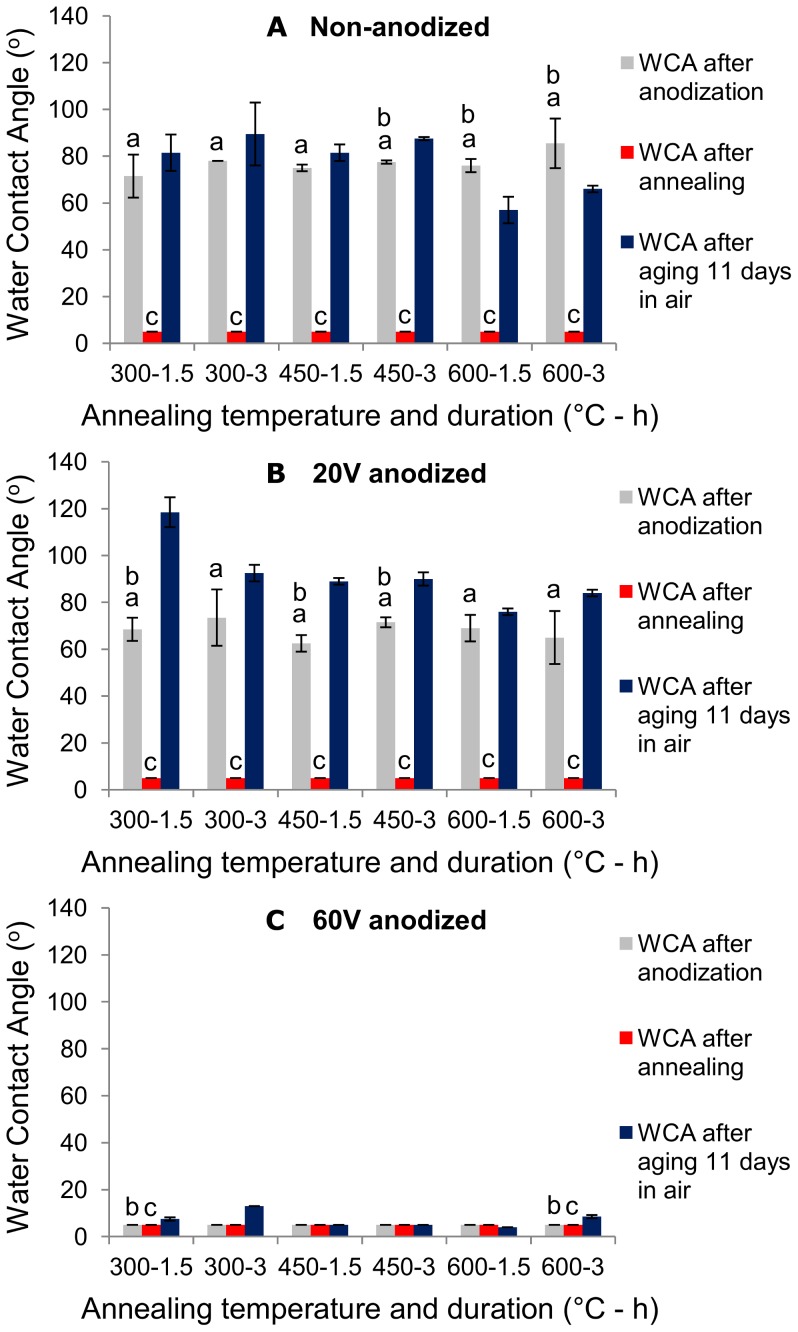
WCA measurements of the samples fabricated at different anodization and annealing conditions.WCA are shown for (A) not anodized samples, (B) 20 V anodized samples and (C) 60 V anodized samples. 60 V anodized samples possess low WCA after anodization and they are able to maintain their hydrophilicity when aged in air up to 11 days. The x-axis indicates the temperature and duration of annealing [Temp (°C)- Time (h)]. a: p<0.05 compared to annealed group, b: p<0.05 compared to aged group, c: p<0.05 compared to aged group. Error bars show standard deviation for n = 2 samples.